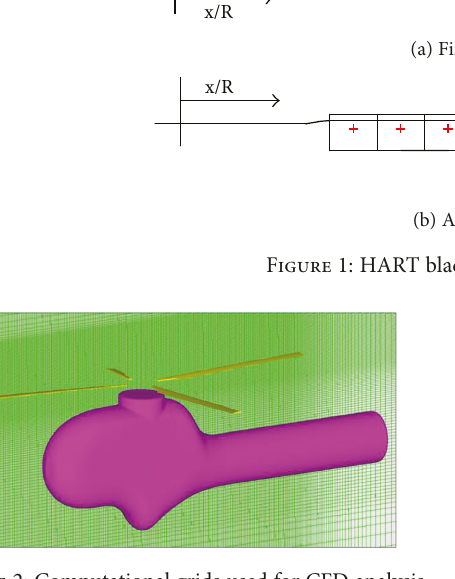
Figure 2: Computational grids used for CFD analysis.